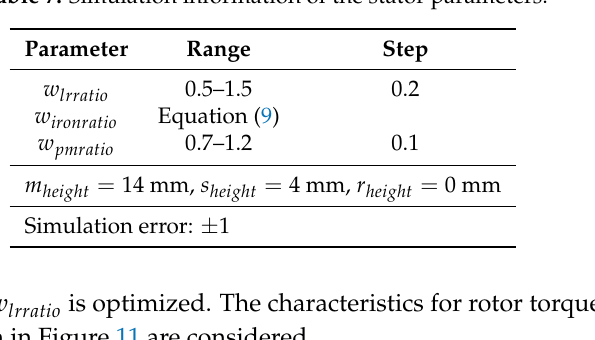
Table 7. Simulation information of the stator